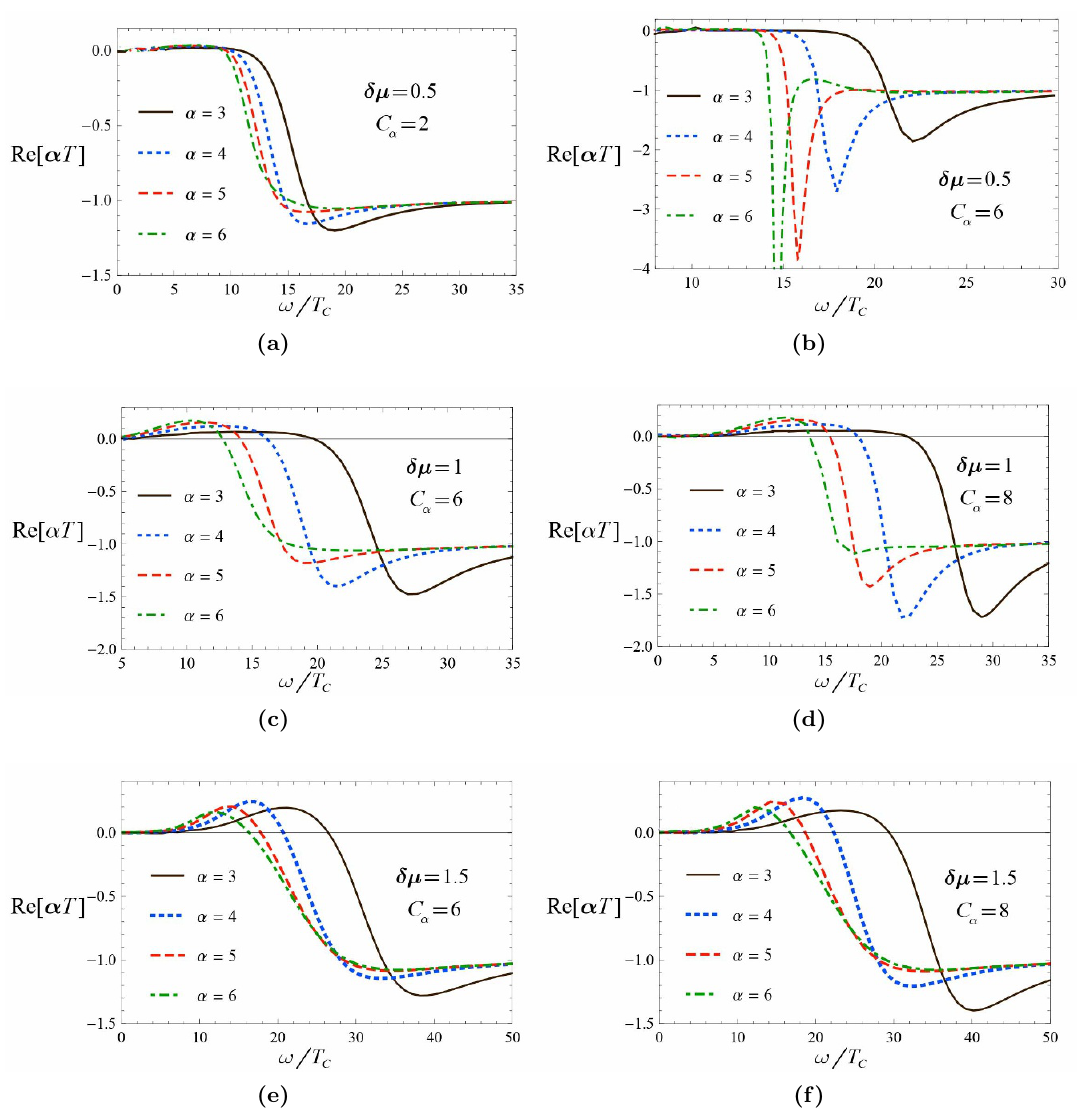
Figure 20. The real part of thermo-electric conductivities in terms of !=T c for function F ( ) = 2 + C (cid:11) with (cid:11) = 3 ; 4 ; 5 ; 6 (solid curve, dotted curve, dashed curve, and dot-dashed curve). Each (cid:11) row is related to the systems with the same imbalance; we have (cid:14)(cid:22) = 0 ; 0 : 5 ; 1 ; 1 : 5 from up to